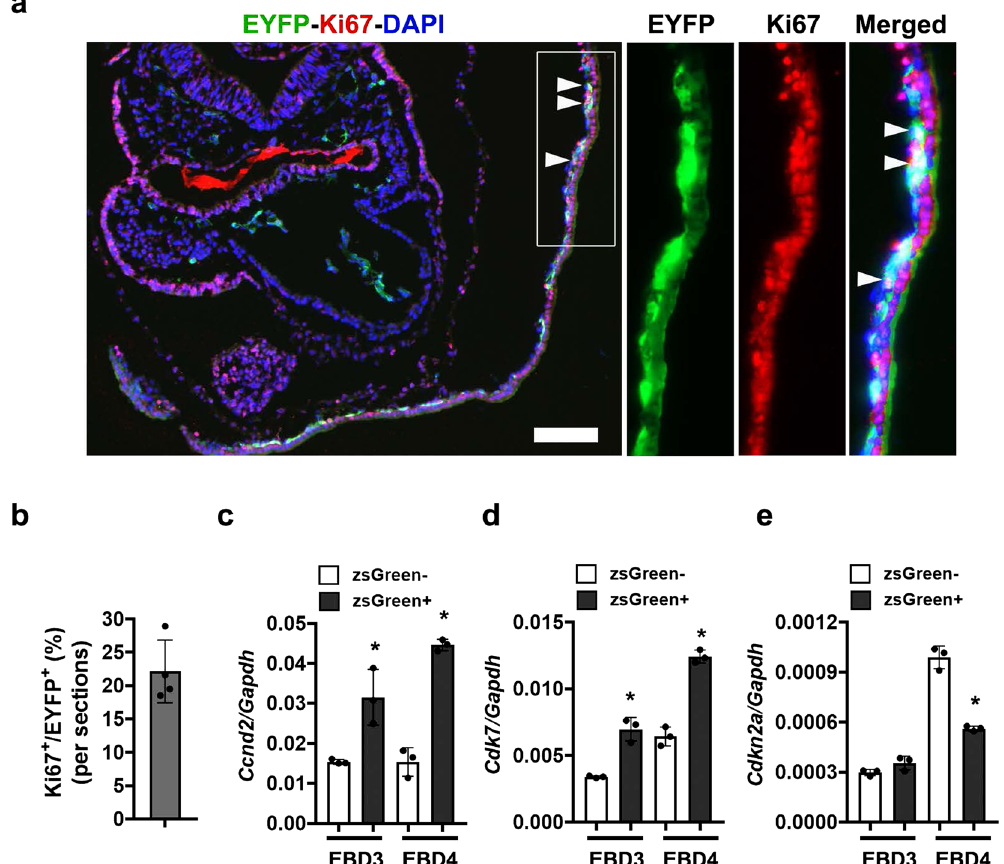
Figure 2. Etv2 is associated with cellular proliferation during embryogenesis. ( a ) Immunohistochemical analysis of transgenic Etv2 - EYFP mouse embryos 5 at E8.5. The boxed region is magnified and shown in the right panels. White arrowheads indicate EYFP + /Ki67 + double-positive cells. ( b ) Quantitative analysis of EYFP + and Ki67 + cells in the Etv2-EYFP transgenic embryo sections. ( b – d ) qPCR analysis of cell cycle gene expression from zsGreen − and zsGreen + cells sorted from Etv2 -zsGreen1-DR 11 EBs on D3 or D4 of differentiation. Pro- proliferative cell cycle genes Ccnd2 and Cdk7 , showed increased expression in zsGreen + cells, while expression of Cdkn2a , a cell cycle repressor, was decreased in zsGreen + cells relative to zsGreen − cells. Data are presented as mean ± SEM (n = 3 replicates; * p <